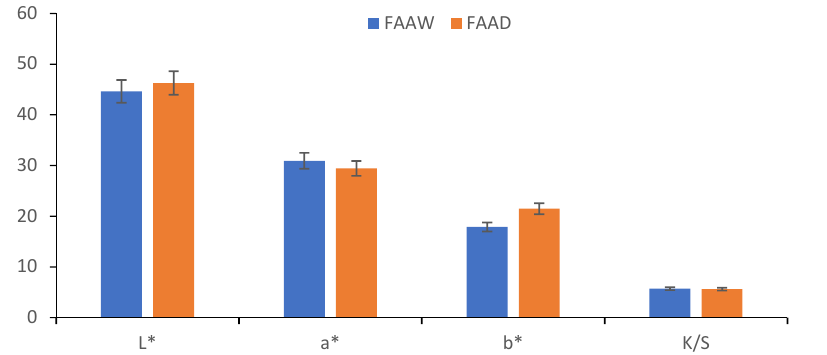
Figure 16. Comparisons between the color characteristics obtained by the functionalizations in acid medium of wool (FAAW) and dye